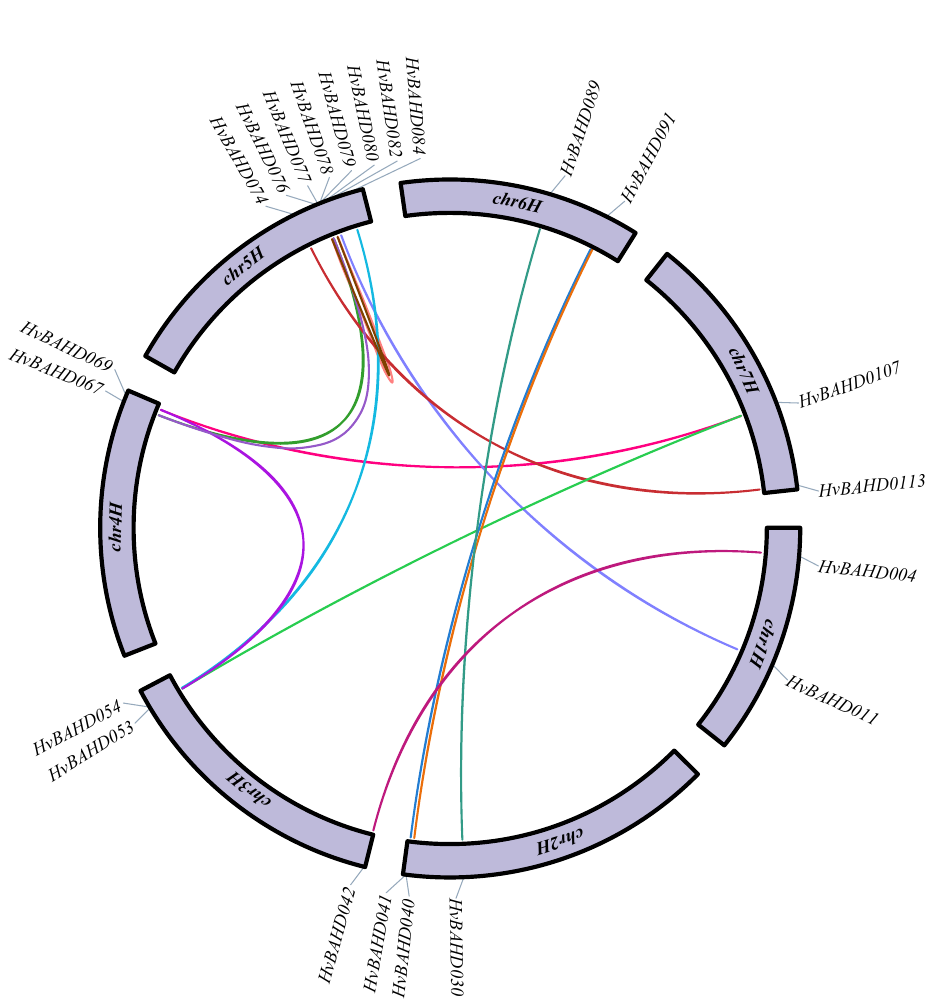
Figure 5. The homologous gene pairs and chromosomal locations of the barley BAHD members. Lines of different colors represents a certain replication relationship between the two genes. The outer circle is the gene name of the associated gene and the distribution position on the chromosome. This picture was constructed by TBtools v1.082 (https:// doi. org/ 10. 1016/j. molp. 2020. 06.